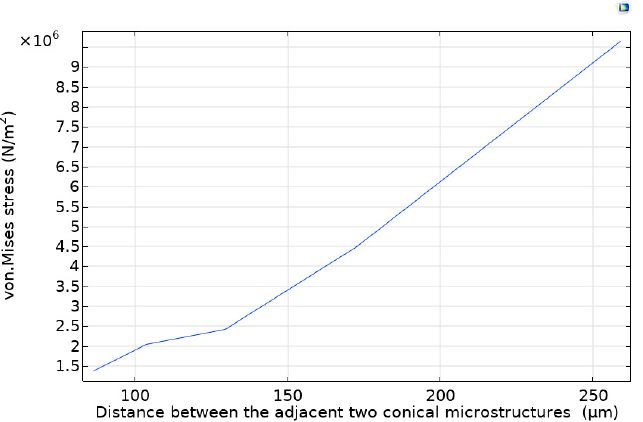
Figure 2. The diagram of variation stress at the vertex of the conical microstructure with the dis- tance between the adjacent two conical